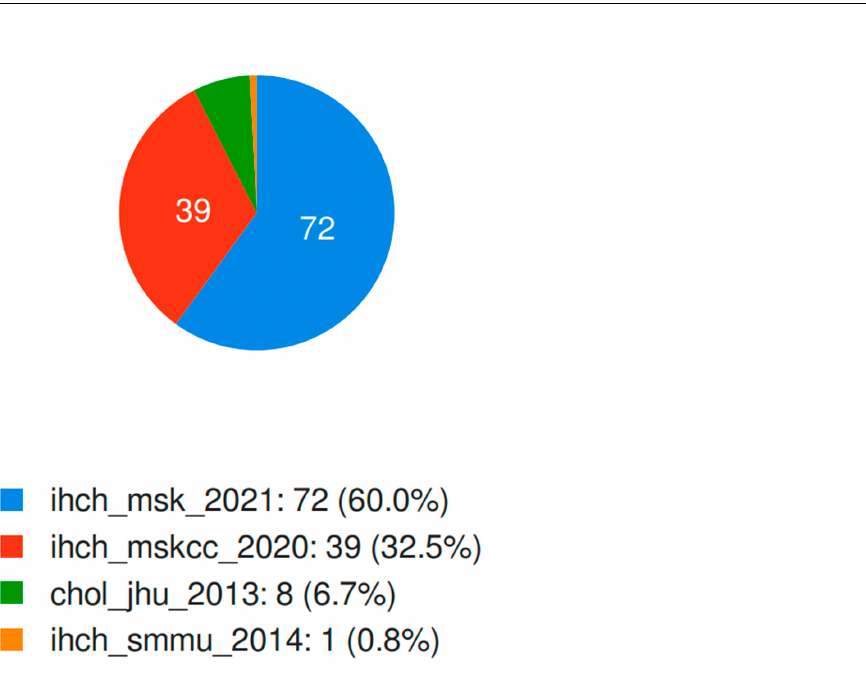
Figure 1. Schematic figure reporting the studies from which BAP1 -mutated intrahepatic cholangiocarcinoma data were extracted.